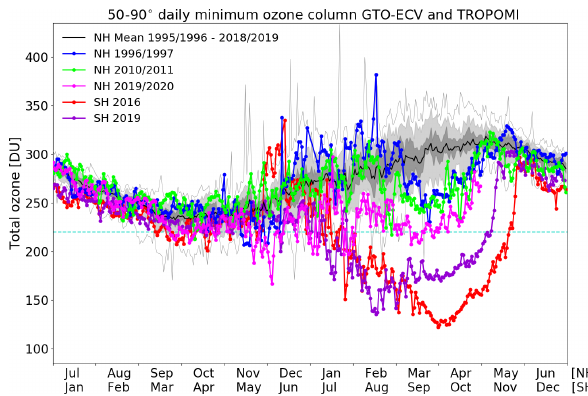
Figure 8. Annual cycle of the minimum total column ozone val- ues (in Dobson Units, DU) in the north polar region between 50 and 90 ◦ N and in the south polar region between 50 and 90 ◦ S derived from the European satellite data record GOME-type To- tal Ozone Essential Climate Variable (GTO-ECV) from July 1995 to June 2019 and TROPOMI data from July 2019 to April 2020. The thick black line shows the GTO-ECV mean annual cycle in the north polar region, with the lowest ozone values in the fall season (October, November) and the highest ozone values in late spring (April, May). The thin black lines indicate the maximum and mini- mum values for the complete time period of satellite measurements starting in 1995. The light grey shading denotes the 10th percentile and the 90th percentile, and the dark grey shading denotes the 30th percentile and the 70th percentile, respectively. The magenta line shows the minimum values for the TROPOMI total ozone in the 2019/2020 season. The blue and green lines show the minimum values for the total ozone in the years 1996/1997 and 2010/2011, respectively. For comparison, the annual cycle of the minimum to- tal column ozone values in the south polar region is shown in the years 2016 (red line) and 2019 (purple line). The Southern Hemi- sphere data are shifted by 6